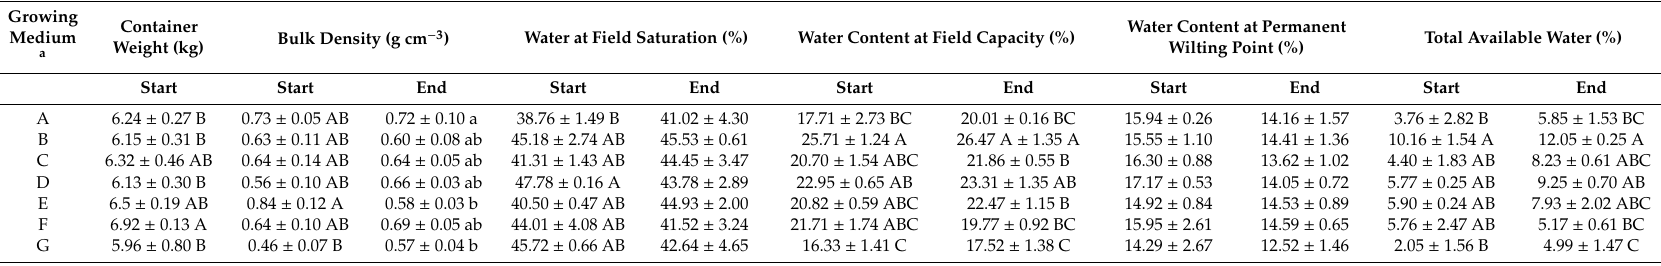
Table 2. Container weight, bulk density, and hydrological properties of growing media recorded at the start (November 2013) and end (October 2015) of the trial. Values are means ( ± standard deviation). Values in a column indicated by di ff erent letters are significantly di ff erent (lowercase p < 0.05, uppercase p < 0.001) based on Tukey’s HSD test.